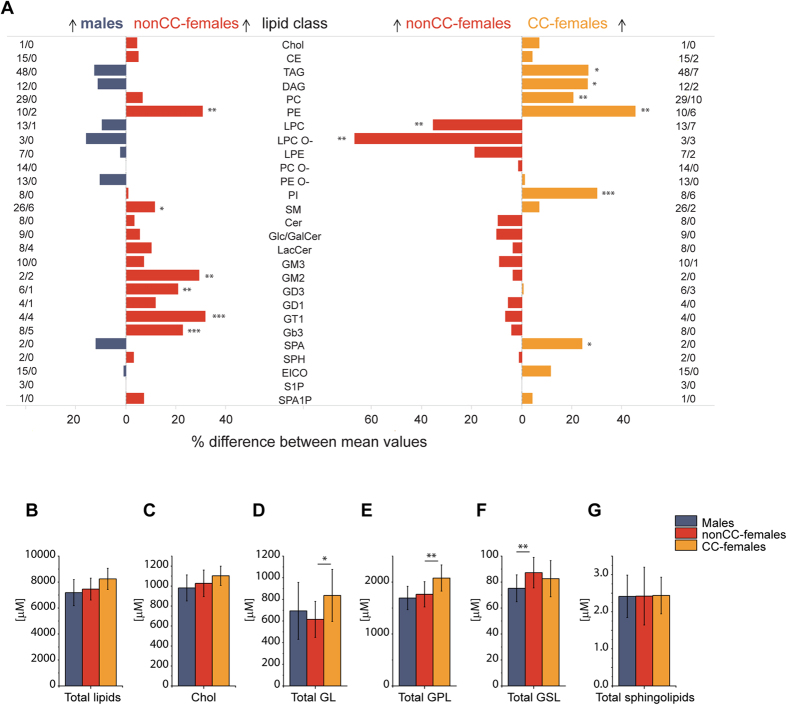
Plasma lipidomes of males, nonCC-, and CC-females differ in many aspects.(A) Relative differences (in %) in the concentration of lipid classes in males (n = 36) vs nonCC-females (n = 16) and in nonCC- vs CC-females (n = 19). Lipid classes are in the middle; numbers at the right and left hand side indicate the total number of detected species in the class/number of species that are significantly (p < 0.01) changed. Arrows indicate higher amount in the respective sub-cohort. (B) Total concentration of lipids; (C) total concentration of Chol; (D) total concentration of GL; (E) total concentration of GPL; (F) total concentration of glycosphingolipids (GSL); (G) total concentration of sphingolipids. *p < 0.05; **p < 0.01; ***p < 0.001 (Mann-Whitney nonparametric test with Benjamini-Hochberg correction). Data are the mean ± SD.